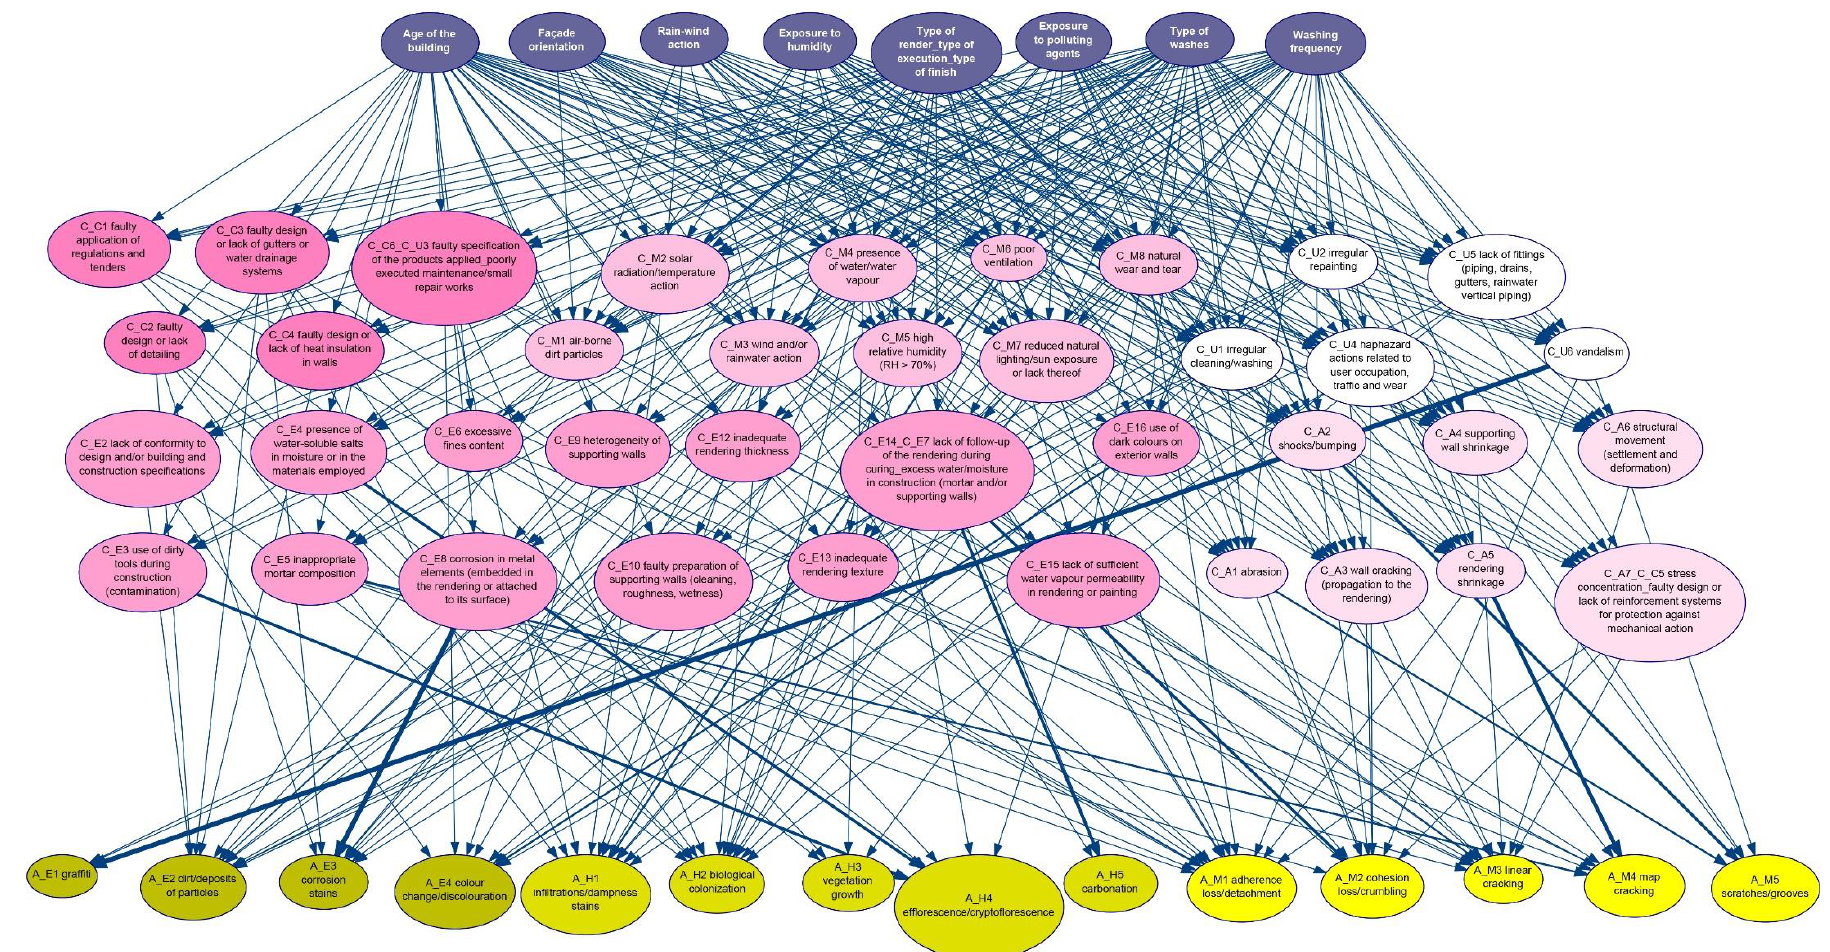
Figure 4. Strength of influence between the nodes of the BN. Both the use of dirty tools (C-E3) and the presence of water-soluble salts in water or construction materials (C-E4) have a significant influence on the occurrence of efflorescence/cryptoflorescence (A-H4) [37,41]; shocks/bumping (C-A2) has a strong influence on the occurrence of scratches or grooves (A-M5).